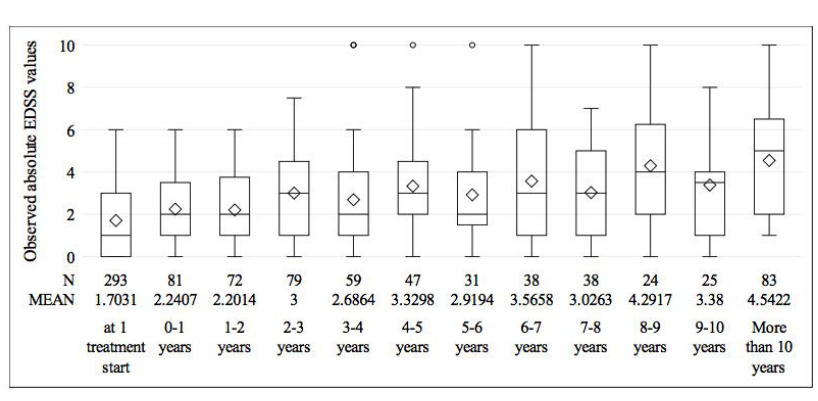
Figure 2. Number of MS cases on -1a. s.c tiw, observed absolute, mean and median EDSS values and SD in yearly intervals from baseline at start during follow-up period β from 1996 to